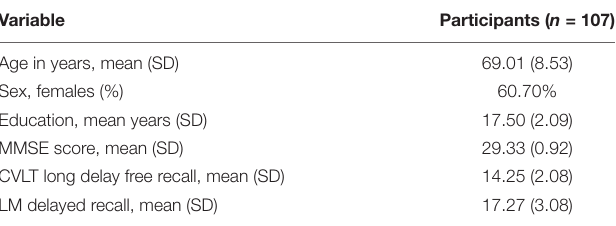
TABLE 1 | Participant